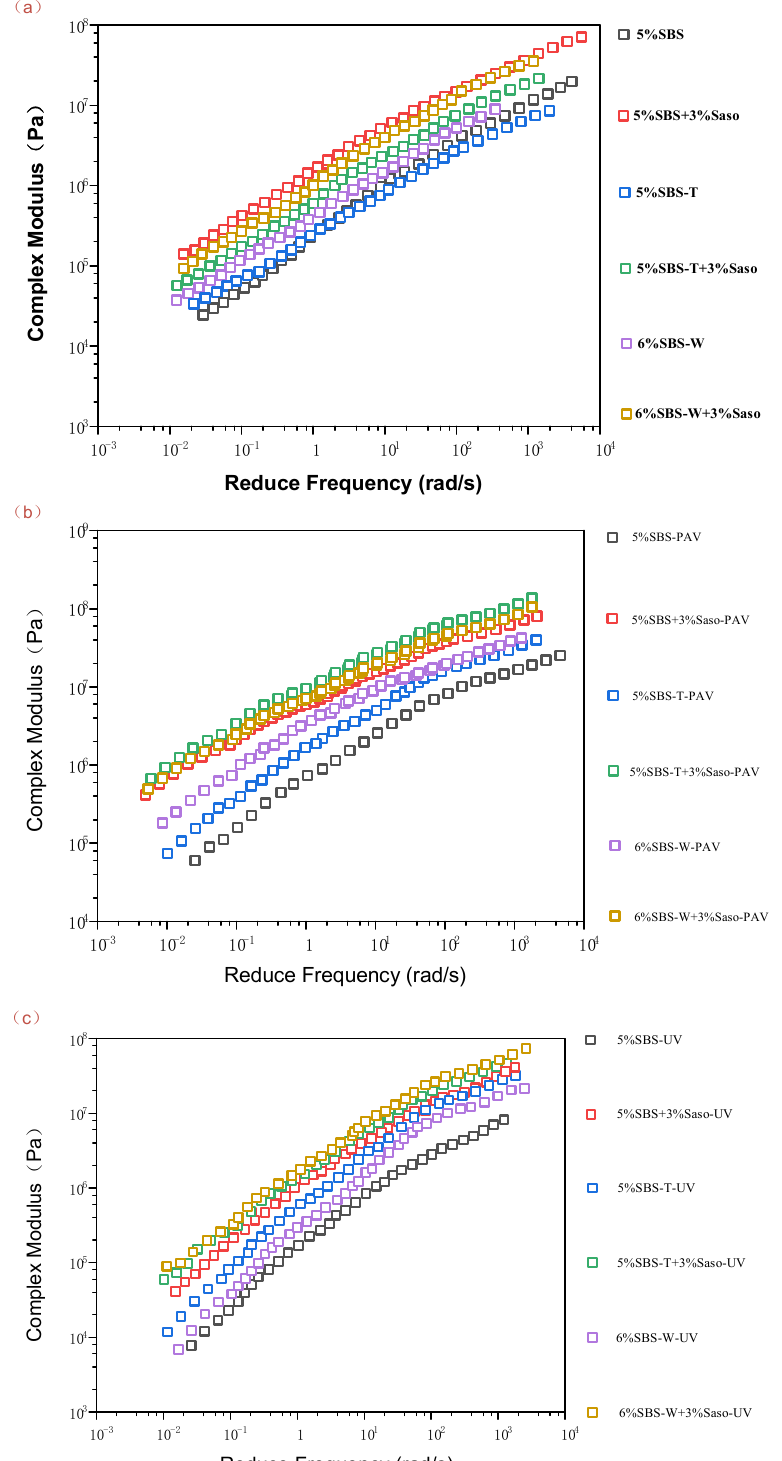
Figure 5. Main curve of dynamic modulus of modified asphalt. ( a ) SBS/Saso; ( b ) SBS-T/Saso; ( c ) SBS ‐ W//Saso. Table 6. Fitting parameters of WLF equation.